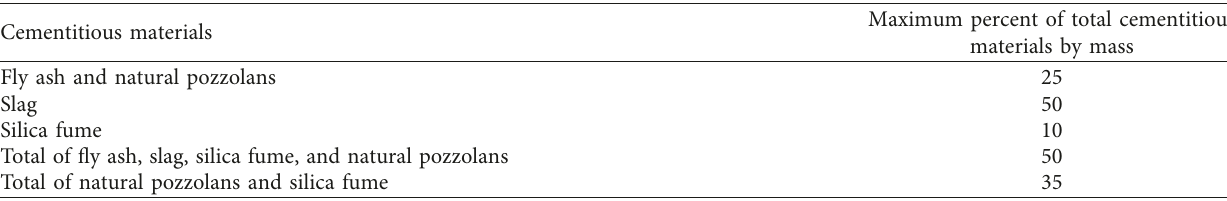
Table 3: Approximate mixing water and target air content requirements for different slumps and nominal maximum sizes of aggregate “Table 3 is reproduced from Kosmatka et al. [39] (under the creative commons attribution license/public domain).” Slump (mm) or air content